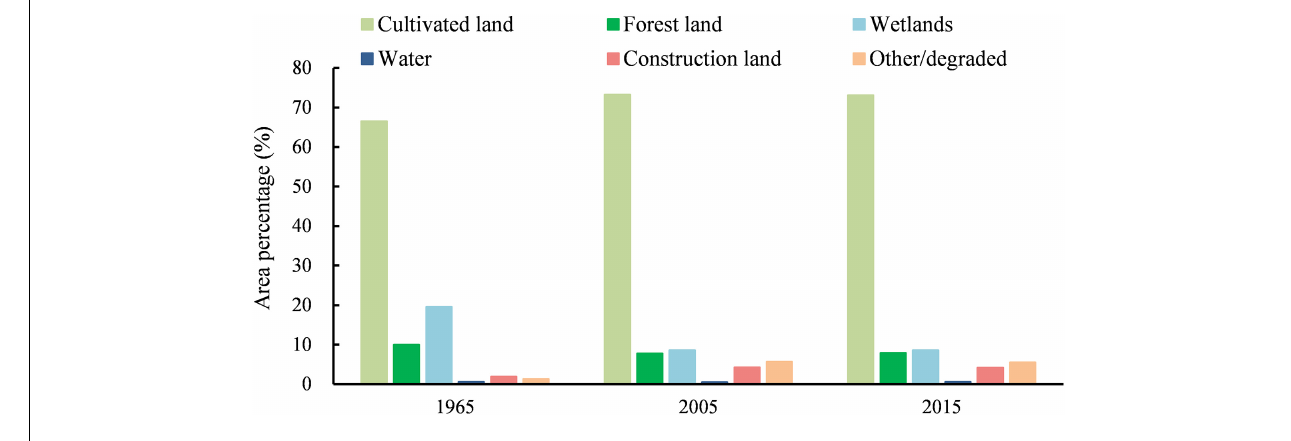
FIGURE 8 | Land use structure change from 1965 to 2015.